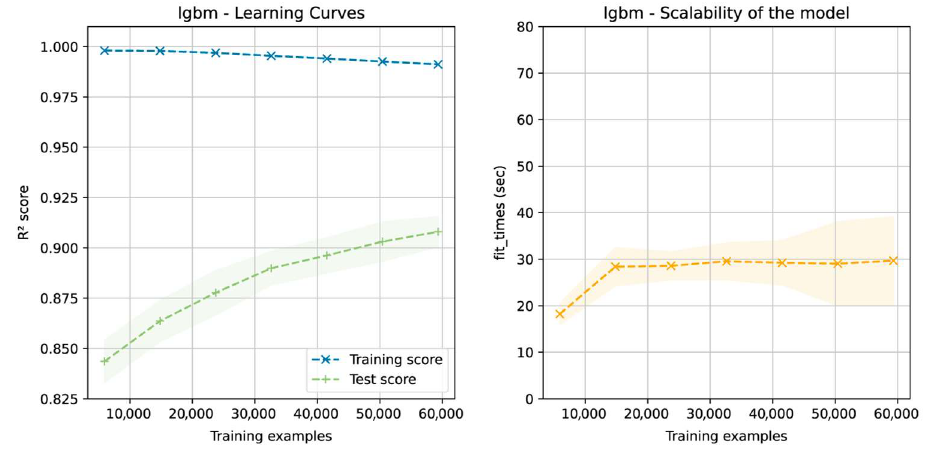
Figure 14. Learning curves and training time according to training set size.